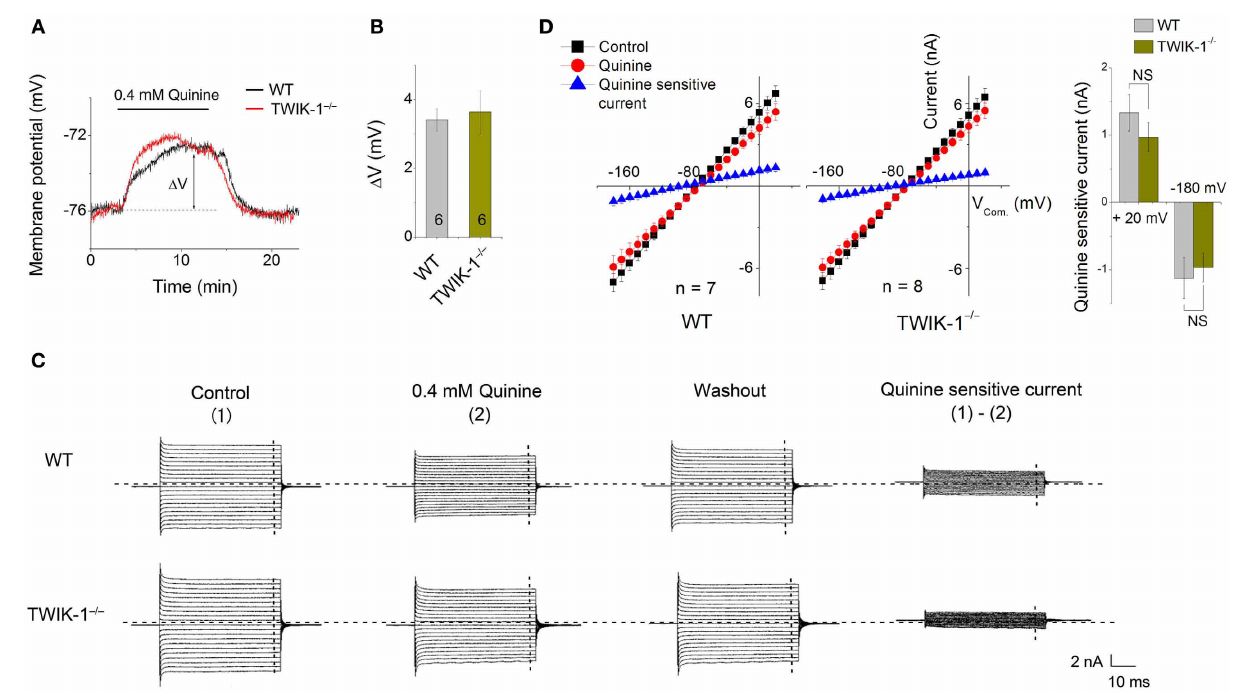
FIGURE 4 | Effects of quinine on astrocyte membrane potential and passive conductance in WT and TWIK-1 − / − mice. (A) 0.4mM quinine induced comparable amplitude of Vm depolarization in both WT and TWIK-1 − / − astrocyte. (cid:2) V indicates the plateau amplitude of Vm depolarization at 8min of quinine application. (B) Summary of (cid:2) V from both genotypes. (C) The representative whole-cell passive